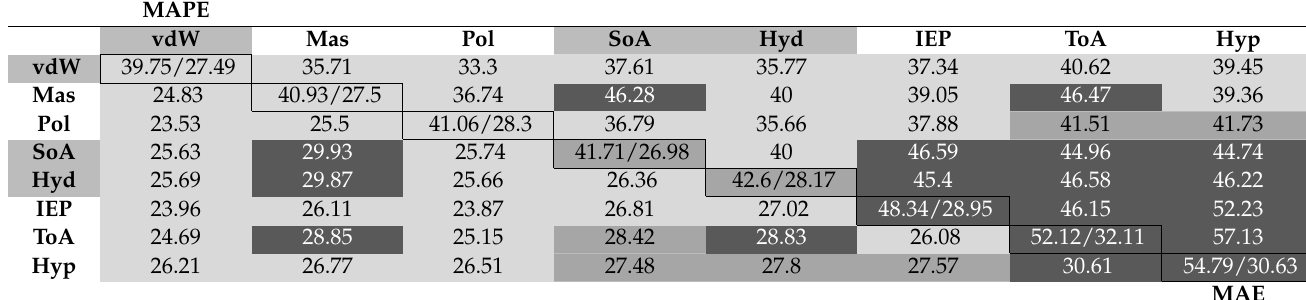
Table 2. Summary of glycation probability errors (MAPE/MAE) for the single–case/two–case predic- tive approaches. We report the MAPE values in the upper diagonal matrix, and MAE values in the lower diagonal. The main diagonal shows the MAPE and MAE values for the case 1, respectively. Both errors are also characterized by gray shades, to describe if we have a high (clear gray), average (medium gray), or low accuracy (dark gray) prediction value. Hyd: hydropathy; Hyp: